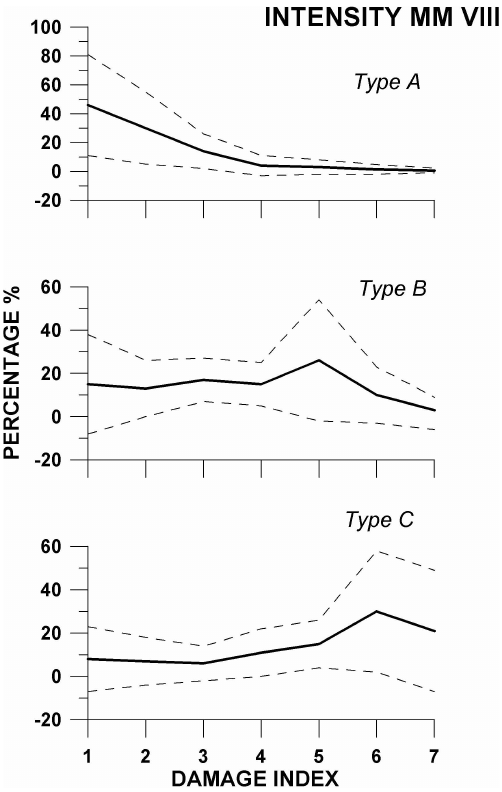
Fig. 6. Curves corresponding to the DPM-2007 (VIII MM intensity) for three types of buildings. The mean values (heavy lines) and their standard deviations (dashed lines) are